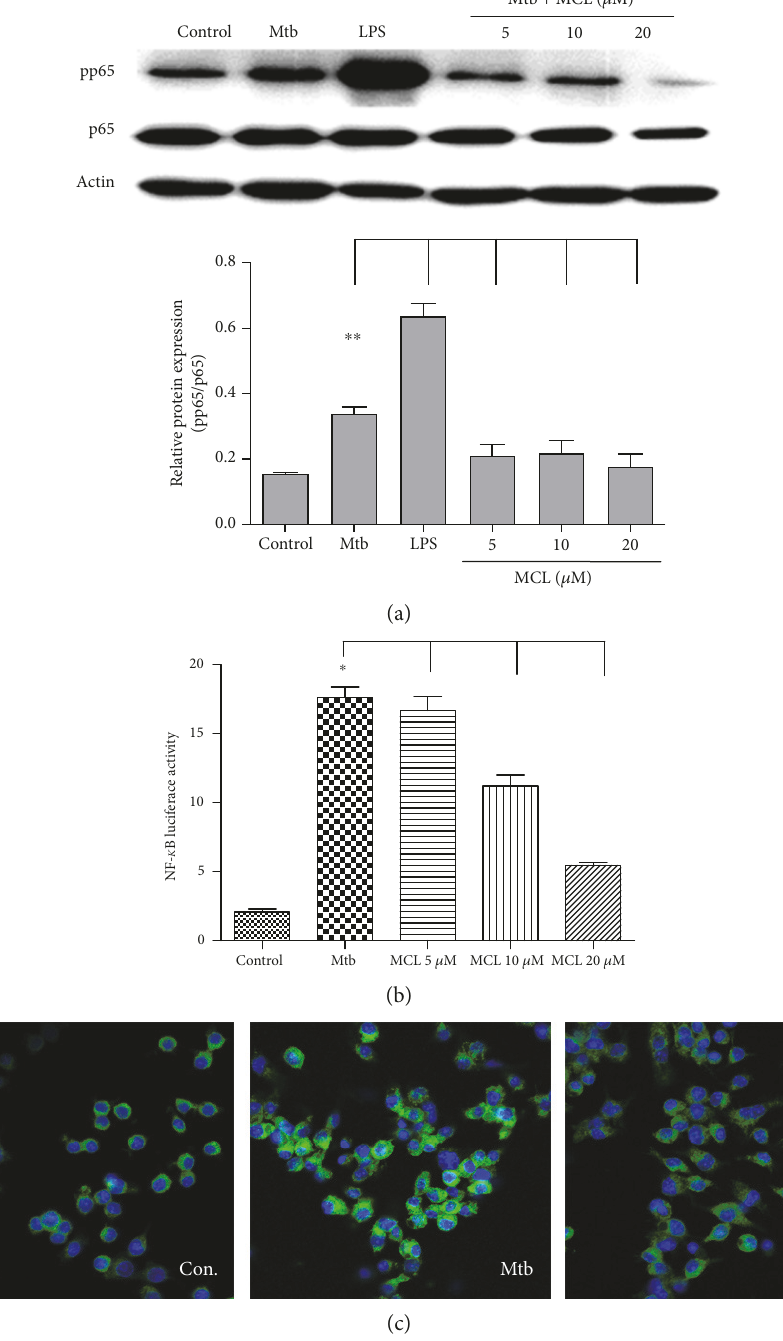
Figure 5: MCL inhibits Mtb-triggered NF- κ B activation. Raw264.7 cells (1 × 10 6 /well) were seeded in 6-well plates and infected with Mtb for 4hrs. Cells were washed by PBS and treated with MCL (10 μ M) for indicated time courses. Phosphorylation of p65 and β -actin was detected by Western blot (a). The lower bar graph showed the statistical results for phosphorylation levels of NF- κ B p65 (a). Data are presented as mean ± SD in at least three independent experiments, ∗∗ p < 0 01 . Raw264.7 cells (3 × 10 5 /well) were cotransfected with NF- κ B luciferase reporter plasmid and pRL-TKR Renilla luciferase plasmid as previous study [34]. After 30 hr, cells were infected with H37Ra at MOI of 10 and treated with MCL (10 μ M) for 12 hr, and the luciferase activities were measured (b). Data are shown with the means ± SD ( n ≧ 3 ). ∗ p < 0 05 . Raw264.7cells (3 × 10 5 /well) were plated in climbing slice and followed by appropriate treatment. Immuno fl uorescence